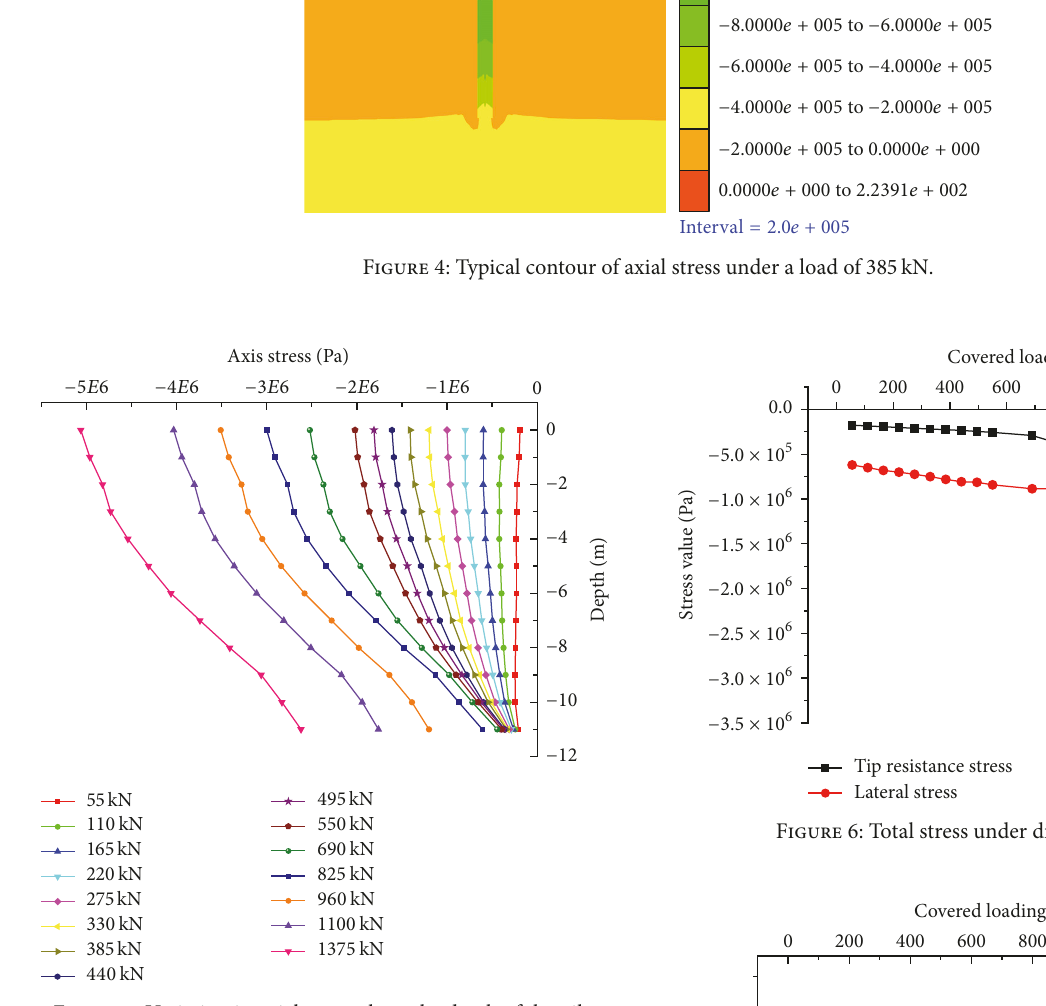
Figure 5: Variation in axial stress along the depth of the pile.